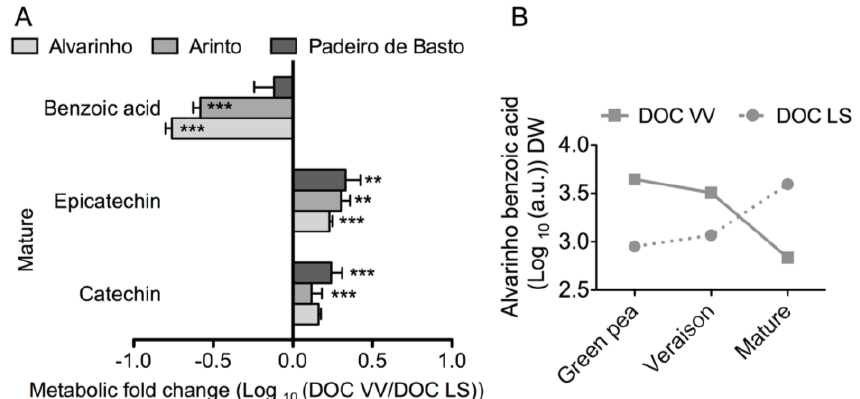
Figure 6. Secondary metabolites in grape berries from Alvarinho, Arinto and Padeiro de Basto from the DOC VV and DOC LS regions. The levels of benzoic acid, catechin and epicatechin at the mature stage are the logarithmic transformed fold change (DOC VV/DOC LS) of berries from Alvarinho, Arinto and Padeiro de Basto ( A ); Logarithmic benzoic acid levels of Alvarinho during grape berry development and ripening ( B ). Columns represent the means ± SE ( n = 3); asterisks denote the